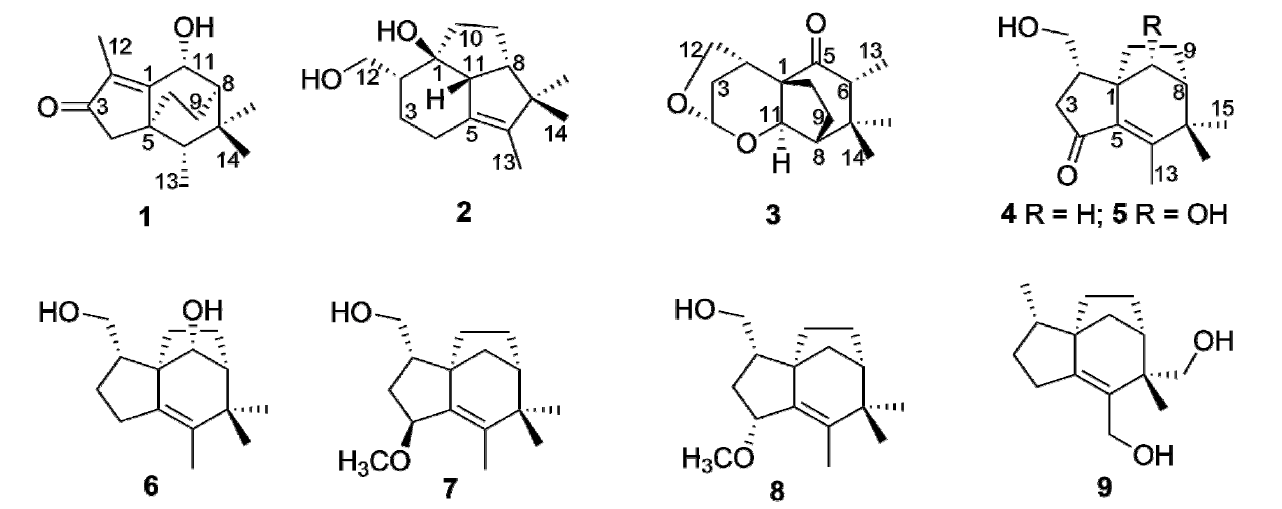
Figure 1. Structures of sesquiterpenoinds 1 – 9 from agarwood.